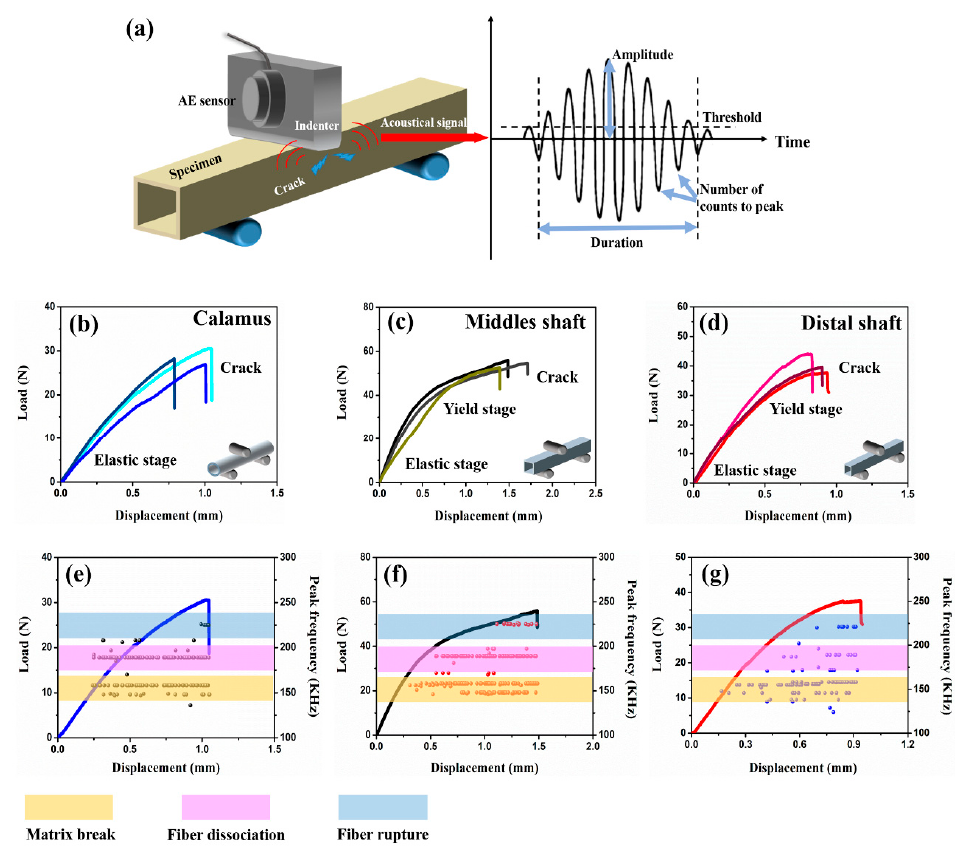
Figure 7. Experimental load-displacement behavior and real-time acoustic emission (AE) peak frequency signals of the calamus, middle shaft and distal shaft. ( a ) Illustration of the AE set-up and the signal characteristics. The load-displacement curves of ( b ) calamus, ( c ) middle shaft and ( d ) distal shaft under flexural load, respectively. Representative curves with related AE signals of ( e ) calamus, ( f ) middle shaft and ( g ) distal shaft under flexural load, respectively.